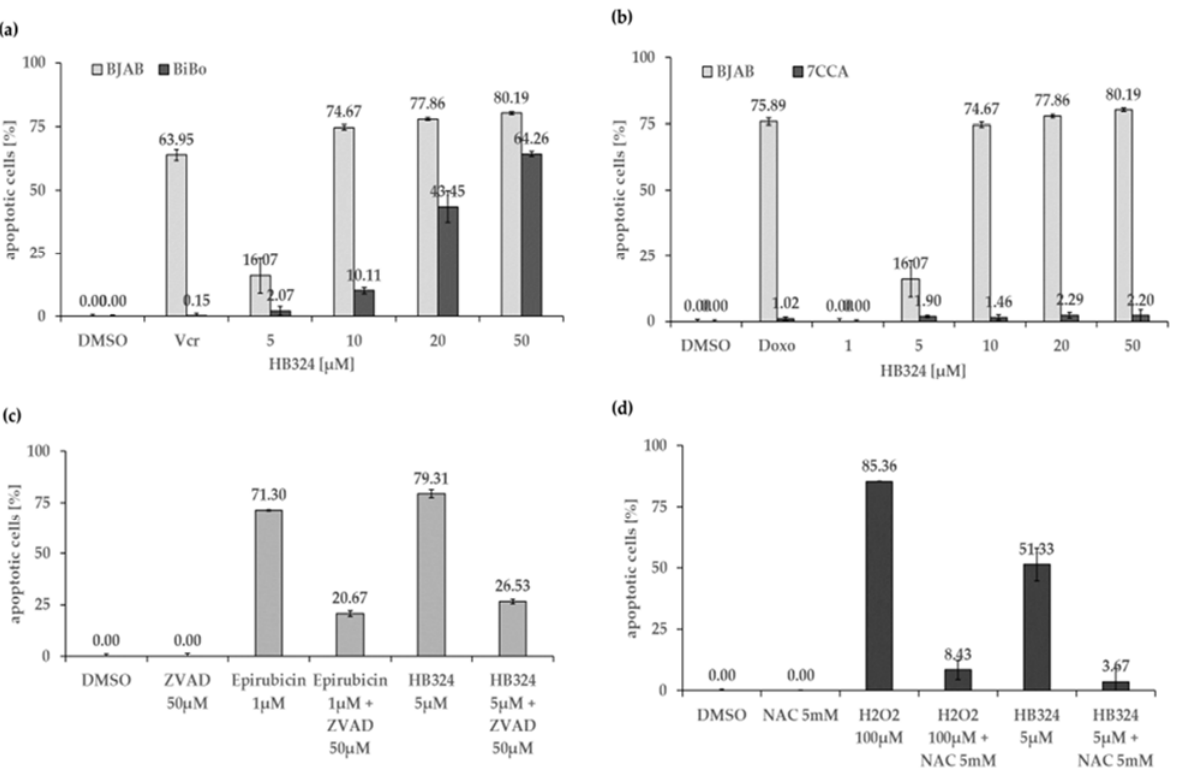
Figure 4. ( a ) Apoptosis induction by HB324 in BJAB and vincristine-resistant BJAB (BiBo) cells after 72 h. Solvent treated cells (0.5% DMSO) served as the control and 5.6 nM vincristine (Vcr) served as the positive control. Values of DNA fragmentation are given as mean percentages of cells with hypodiploid DNA ± S.D (n = 3). ( b ) BJAB and doxorubicin-resistant BJAB (7CCA) cells were treated with HB324 for 72 h. Solvent treated cells (0.5% DMSO) served as the control, and 184 nM doxorubicin (Doxo) was pipetted in both cell lines to prove the resistance. Values are given in percentage of apoptotic cells as mean values ± SD (n = 3). ( c ) Nalm-6 cells were incubated for 72 h with 1 µM epirubicin as the positive control or 5 µM HB324 after pretreating part of the cells with 50 µM of the pancaspase inhibitor Z-VAD-FMK (ZVAD) 1 h prior. Solvent treated cells (0.5% DMSO) served as the control. Nuclear DNA fragmentation was quantified by flow cytometric determination of hypodiploid DNA. Data are given in % hypoploidy (subG1), which reflects the number of apoptotic cells as mean values ± SD (n = 3). ( d ) Nalm-6 cells were incubated for 72 h with 100 µM H 2 O 2 as the positive control or 5 µM HB324 after pretreating part of the cells with 5 mM of N-acetylcysteine (NAC) 1 h prior. Solvent treated cells (0.5% DMSO) served as the control. Nuclear DNA fragmentation was quantified by flow cytometric determination of hypodiploid DNA. Data are given in % hypoploidy (subG1), which reflects the number of apoptotic cells as mean values ± SD (n = 3).